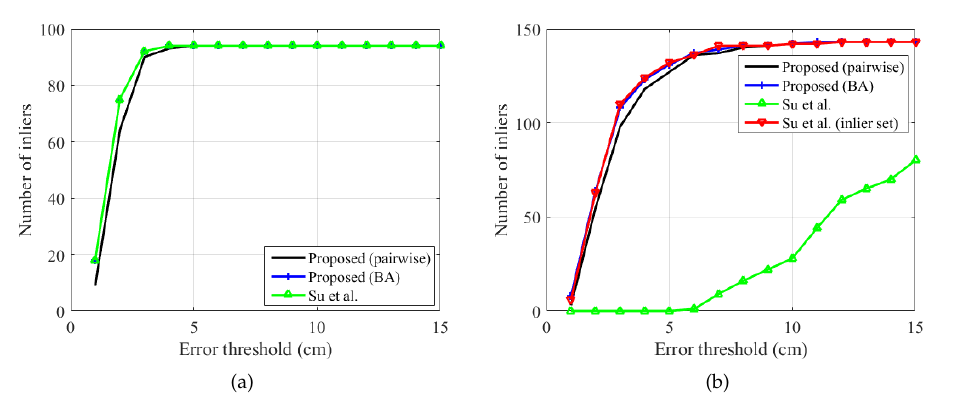
Figure 16. Number of inliers. The figures show the number of triples of corresponding sphere centers whose maximum pairwise distance is less than the error threshold. ( a ) Static set ( N = 95). ( b ) Dynamic set ( N = 164). Refer to the text for more detail. Best viewed in color.